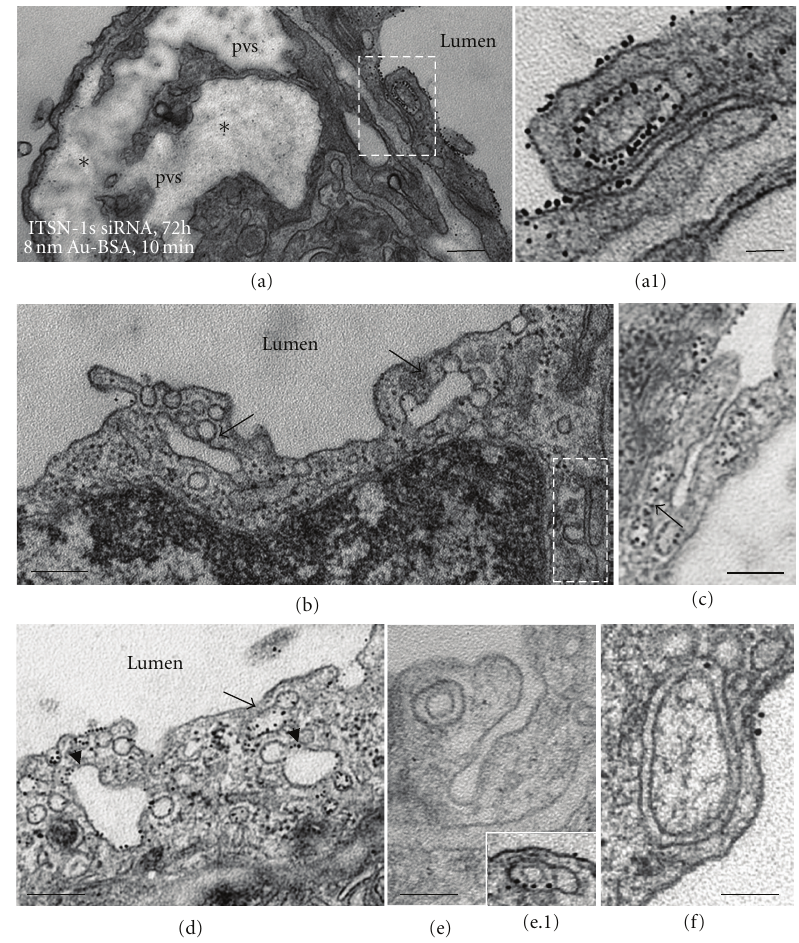
Figure 4: Acute perturbation of ITSN-1s expression induces pleomorphic endocytic/transcytotic intermediates. (a–f) Representative EM images of membranous rings (a, a1, e, e.1, f), tubular elements (b, c, d, arrows) and enlarged endosomes (d, arrowheads), loaded with 8 nm Au-BSA and associated with caveolae-like morphology. Two tubular structures open to the lumen are shown in (c) and (e). The EM image shown in (e) was selected from a mouse lung specimen not perfused with 8 nm Au-BSA. Note also the severe dilation of the perivascular space (pvs) and the proteinaceous edema (a). Bars: 250 nm (a, b); 200 nm (c, d); 150 nm (f); 100nm (a1,